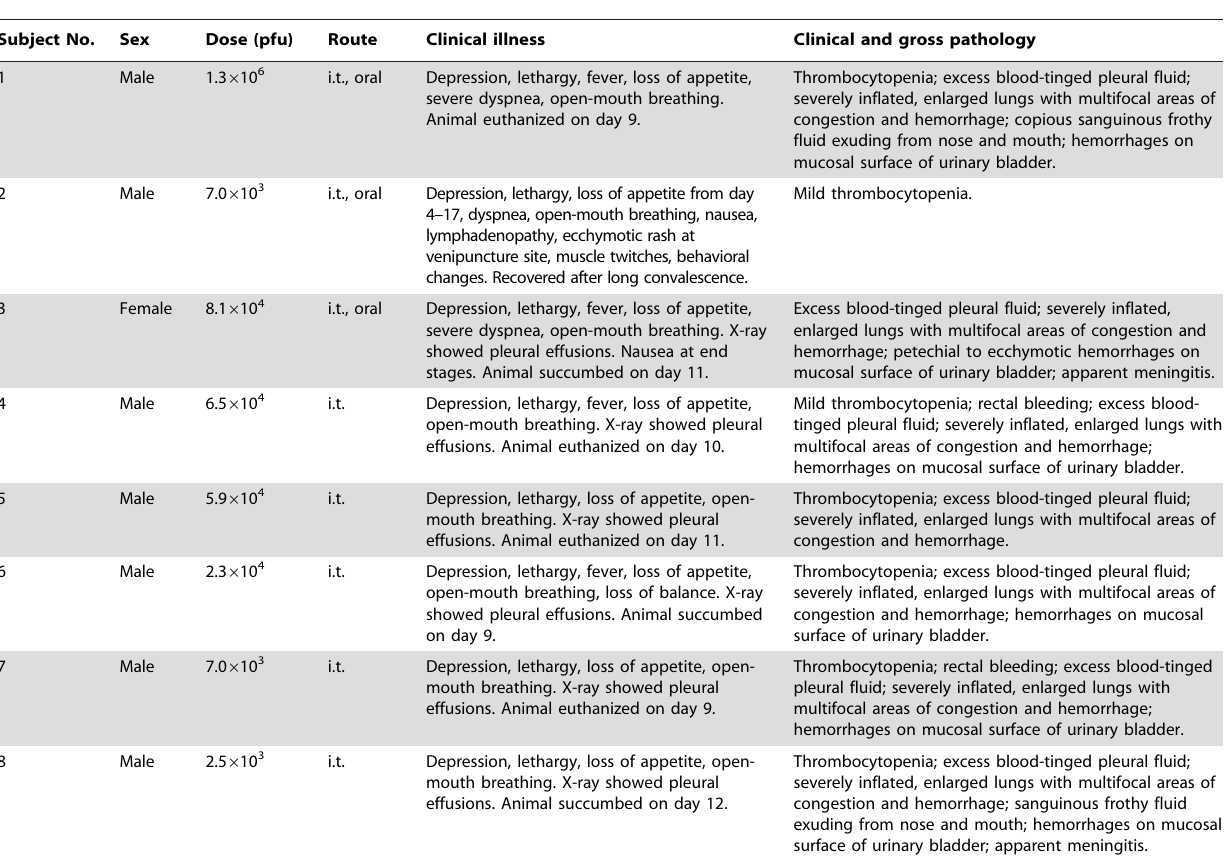
Table 1. Clinical description and outcome of Nipah virus challenged